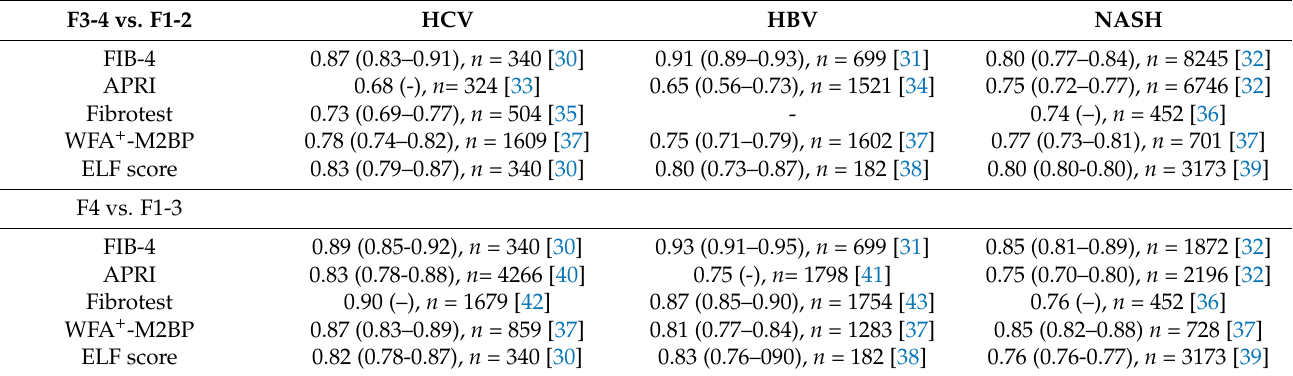
Table 1. Diagnostic abilities of serum biomarkers for advanced fibrosis and cirrhosis. F3-4 vs.